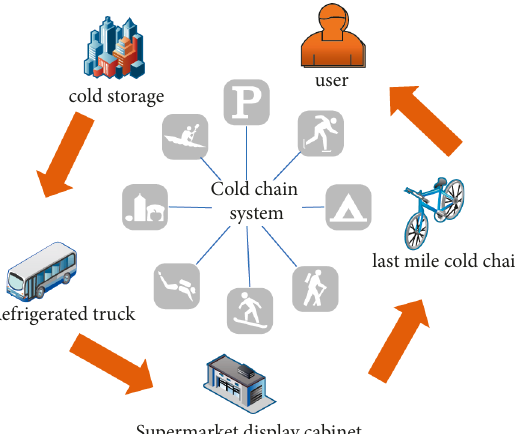
Figure 4: Components of cold chain logistics.